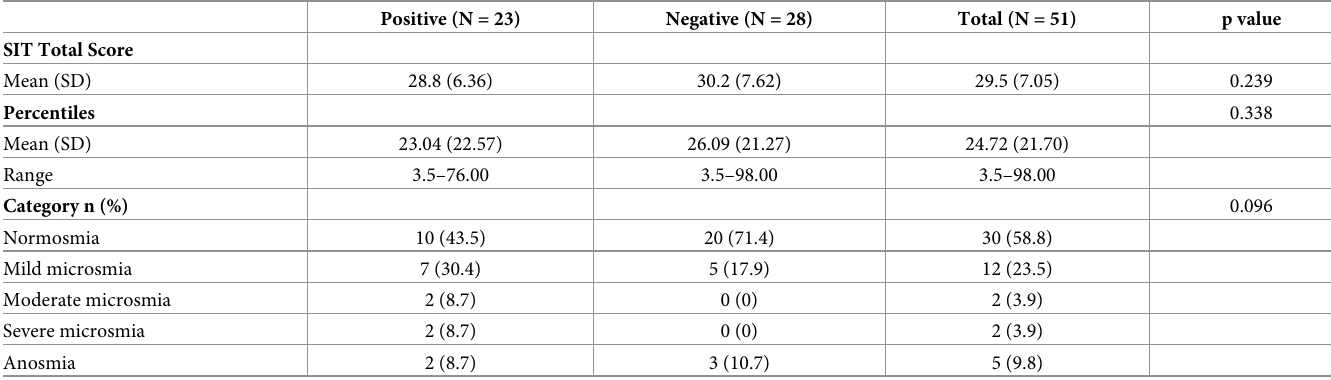
Table 3. SIT scores.